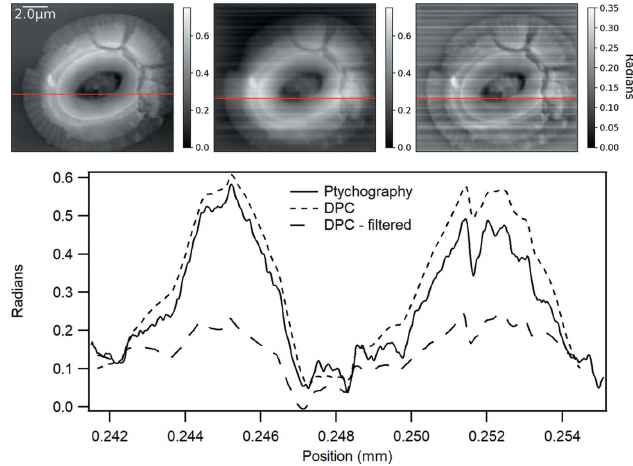
Figure 3 A comparison of DPC and ptychography from a coccolith sample. Top row left, ptychography phase image; middle, DPC phase image; right, DPC high-pass-filtered image. Bottom: comparison of phase line profile (indicated on phase images by a horizontal line) from DPC and ptychography. Note that the line profile from the ptychography has been offset to overlay with the start and end of the DPC line profile. No phase ramp removal was used on the images. The images are similar, albeit with stripes in the DPC, but the higher resolution of ptychography improves contrast in the depressions of the